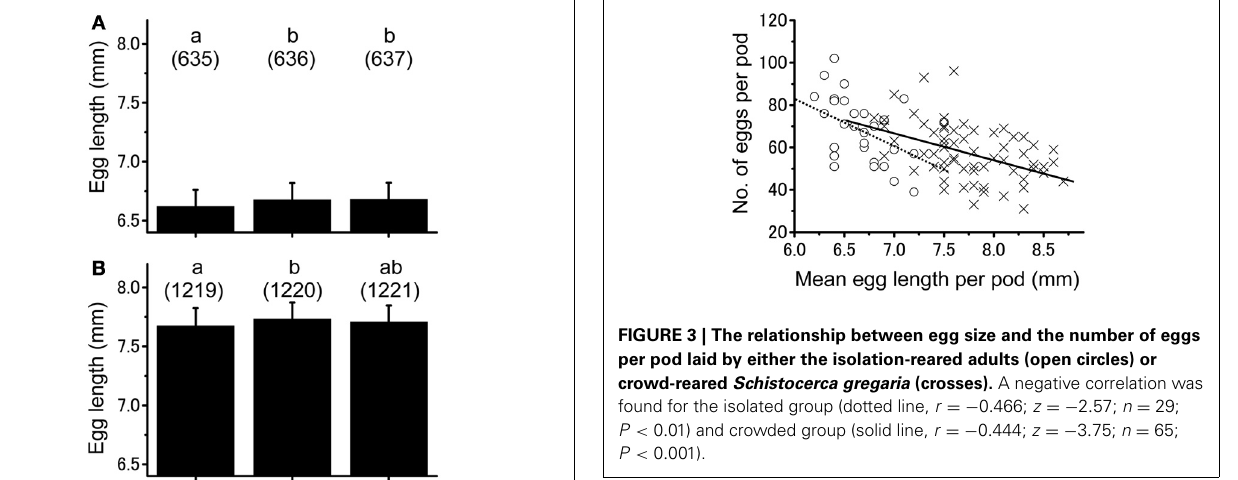
Table 1 | Characteristics of body weights (mg ± SD ) and body coloration of Schistocerca gregaria hatchlings categorized into five hatchling color grades (HCGs).